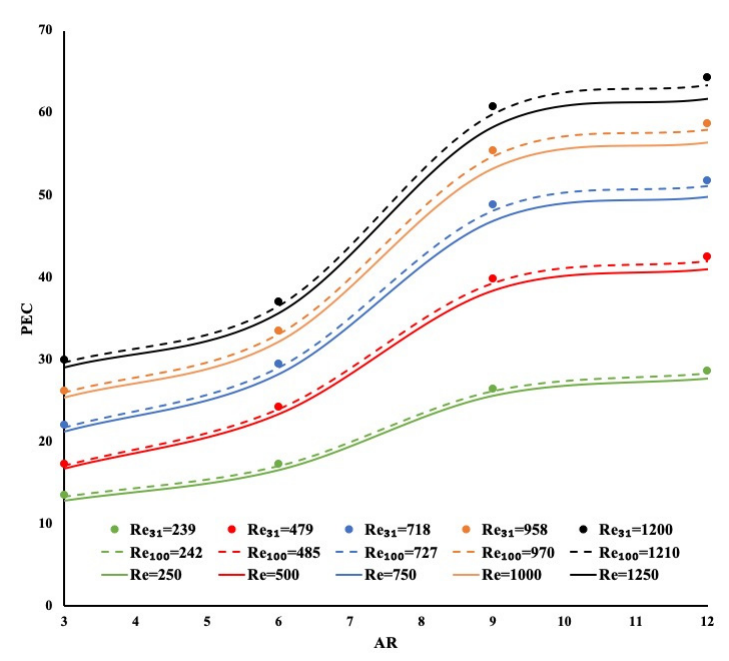
Figure 13. Performance evaluation criteria for all cases.